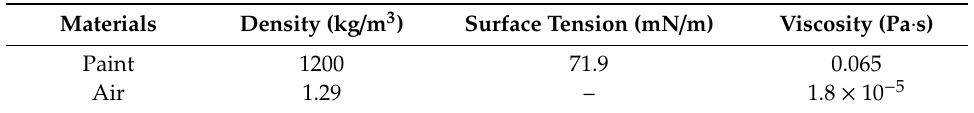
Table 2. Properties of the paint and air.